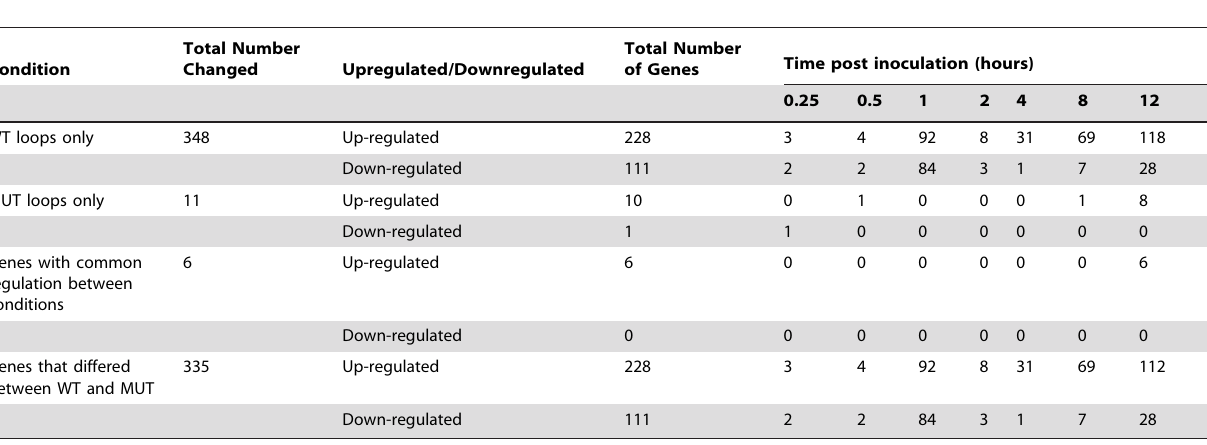
Table 4. Summary of significantly altered genes that overlap between the two statistical methods (Table 2 and